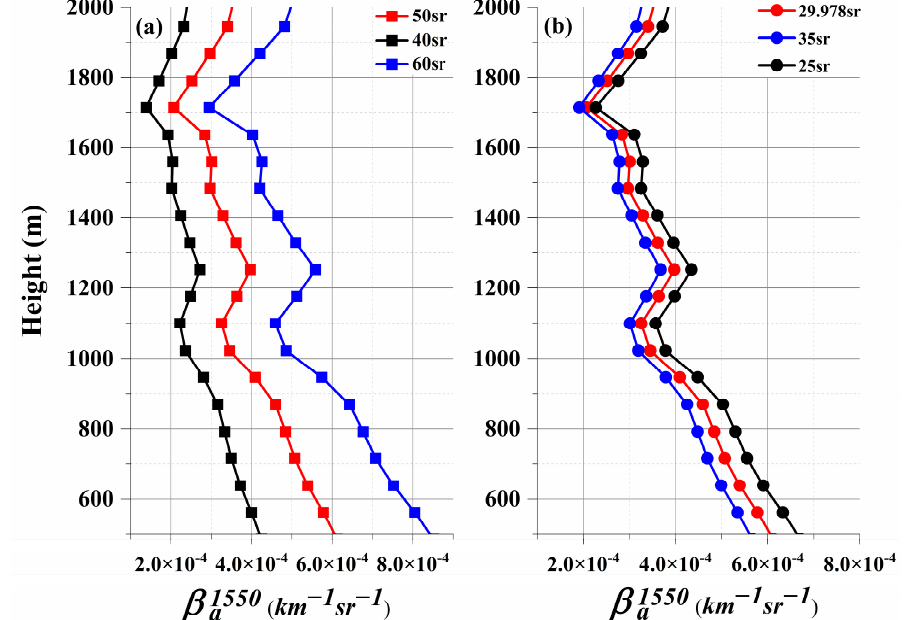
Figure 5. Relationship between lidar ratios and the retrieved aerosol backscatter coefficients. ( a ) When S a 1550 = 29.978 sr , the retrieved β 1550 a changes with different S a 532 s input. ( b ) When S a 532 = 50 sr , the retrieved β 1550 a changes with different S a 1550 s input.